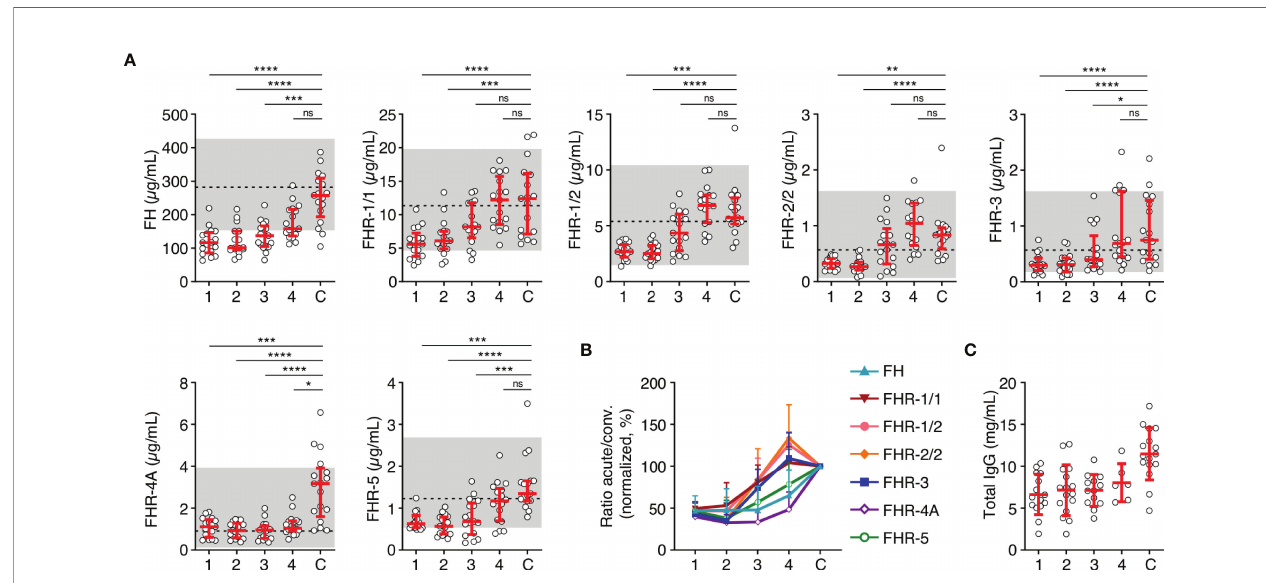
FIGURE 2 | FH family protein level dynamics during the acute stage of MD. (A) FH family protein levels in paired samples ( n = 17) as assessed during the fi rst four days of infection (day 1 until day 4), compared with the concentration at convalescence (C) . Shaded area indicates 95% range in healthy patients, with dashed line indicating the median. Friedman test followed by Dunn ’ s multiple comparisons test, with every acute stage dataset compared to the levels found at convalescence. **** p < 0.0001; *** p < 0.001; ** p < 0.01; * p < 0.05; ns, not signi fi cant. (B) FH family protein levels as in (A) , normalized to the levels found at convalescence. (C) Total IgG levels in unpaired samples (maximum n = 16) as assessed during the fi rst four days of infection and at convalescence. The 95% range in healthy patients is not depicted, due to variability of total IgG levels during childhood. Lines depict median and